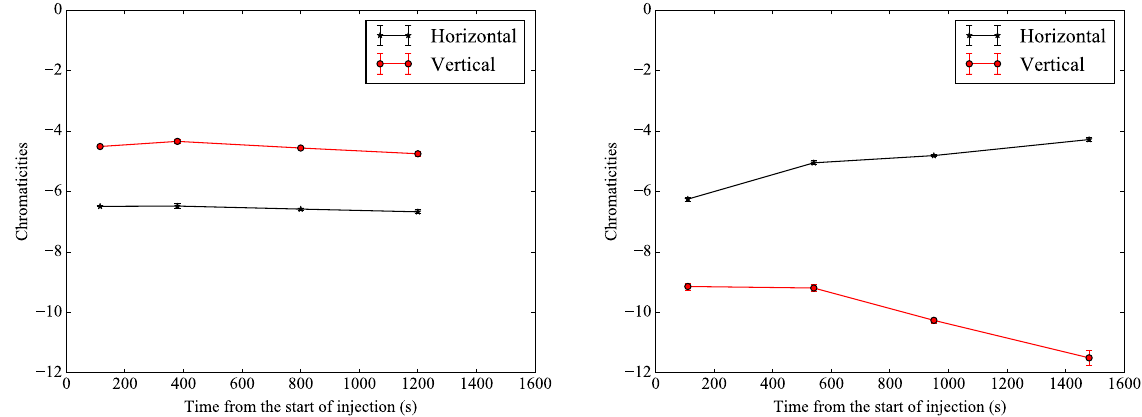
FIG. 10. The left plot shows the measured beam chromaticities after the demagnetization cycle. The right plot shows the drift of measured beam chromaticities after a conventional cycle.